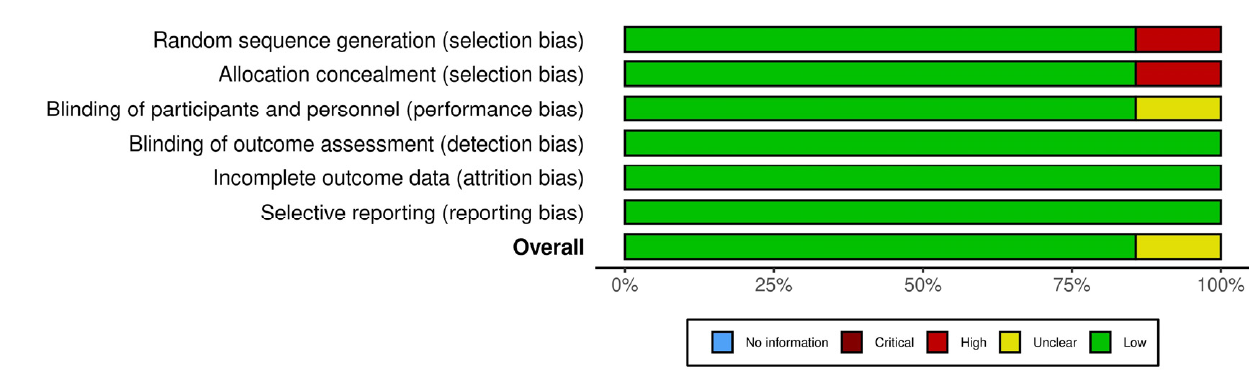
Figure 2. Summary of risk of bias in primary studies